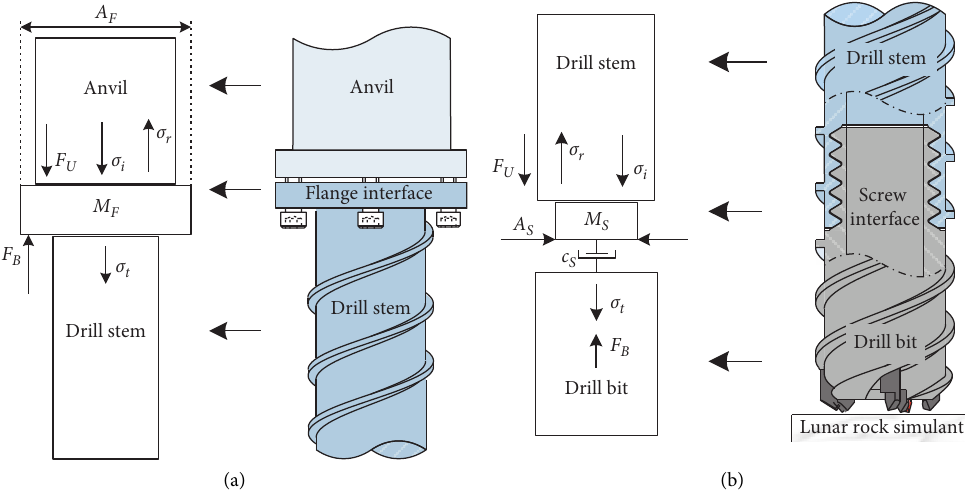
Figure 6: Stress transfer analysis of the flange/screw interface. (a) The rigid body mass model (flange interface). (b) The mass damping model (screw